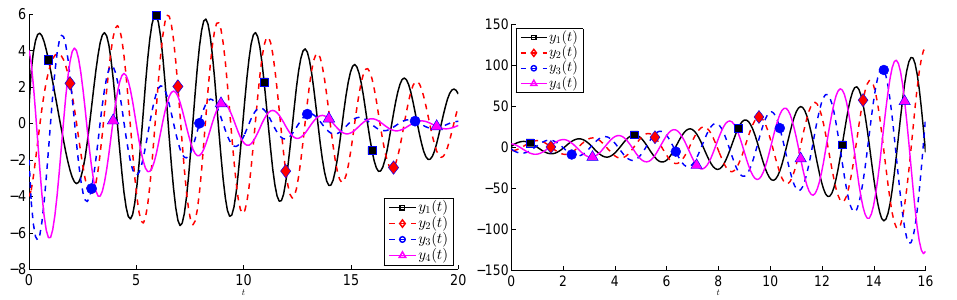
= Ay ( t ) , with q = 2/3, for A = A 0